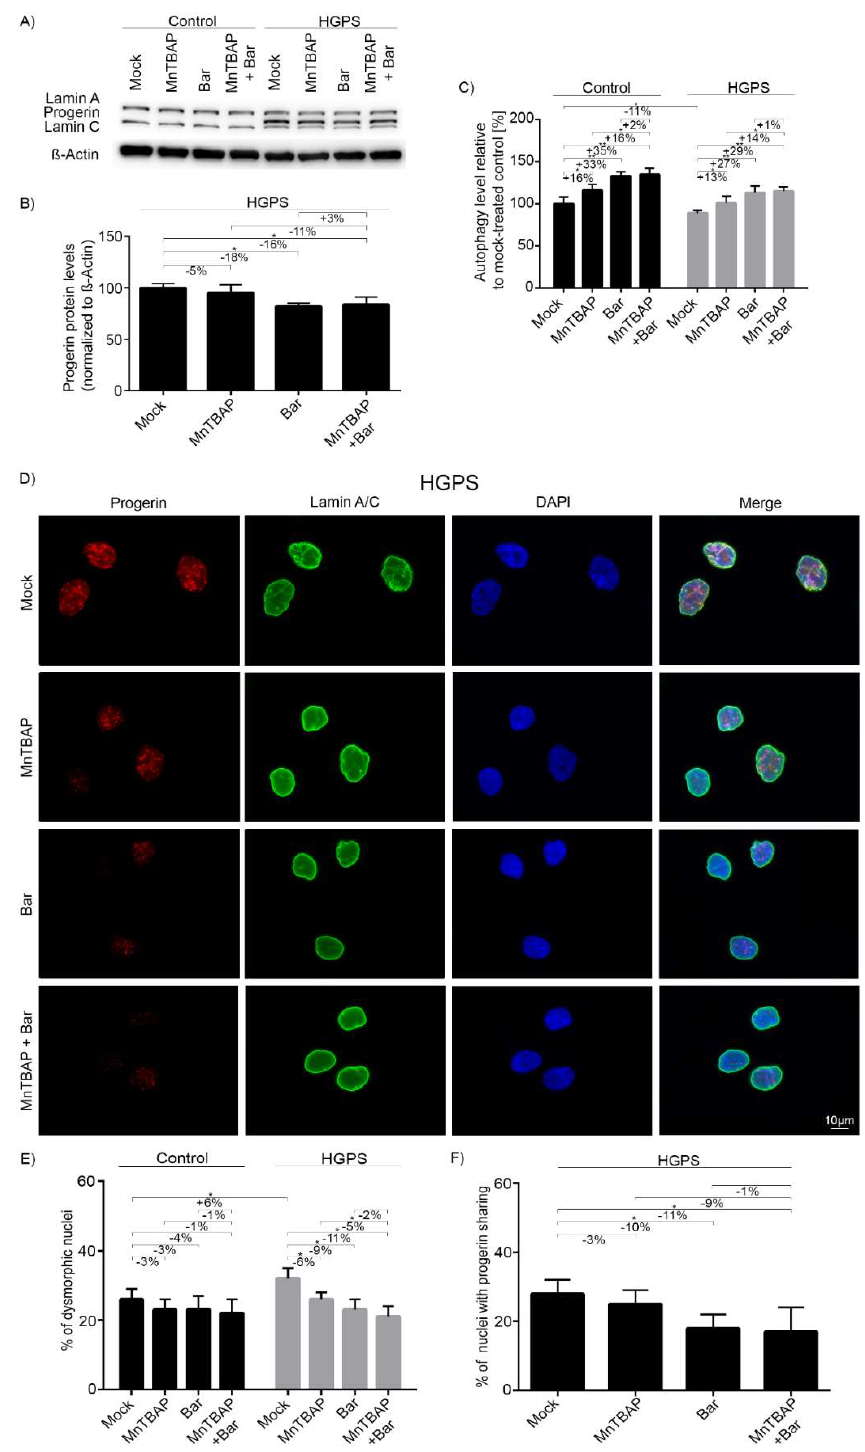
Figure 3. Combined MnTBAP/Bar treatment reduces nuclear abnormalities. ( A ) Representative images of Western blots of lamin A/C after MnTBAP/Bar treatment. Control and HGPS fibroblasts